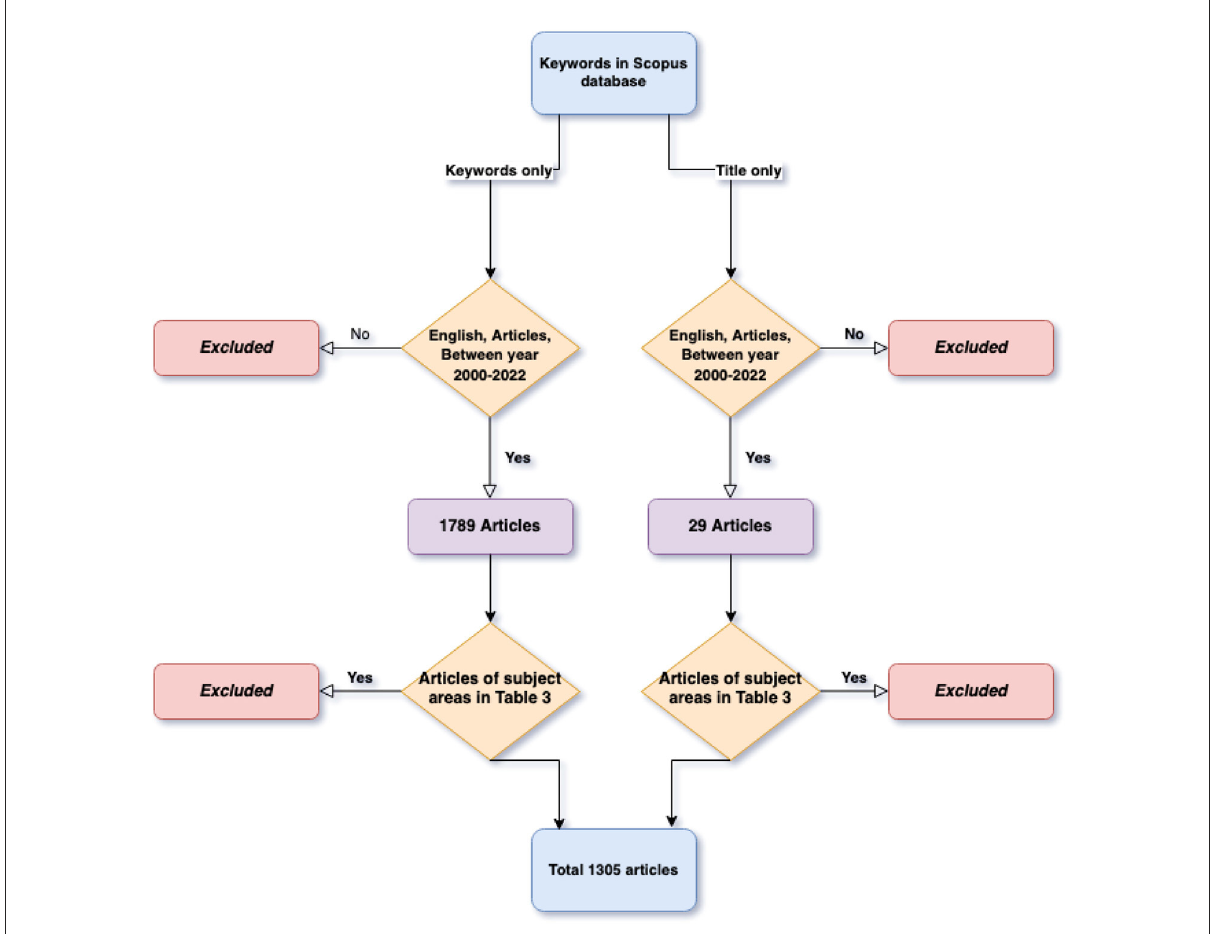
FIGURE2 Flowchart of the literature selection